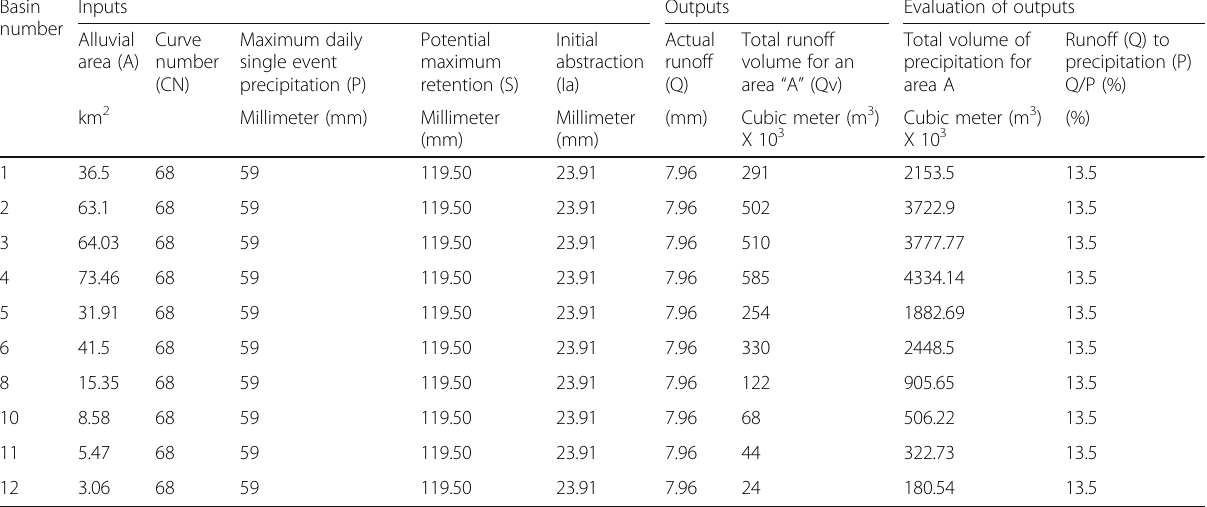
Table 4 Estimation of surface runoff affecting the areas occupied by alluvial sediments Basin Inputs Outputs Evaluation of outputs number Alluvial Curve area (A) number